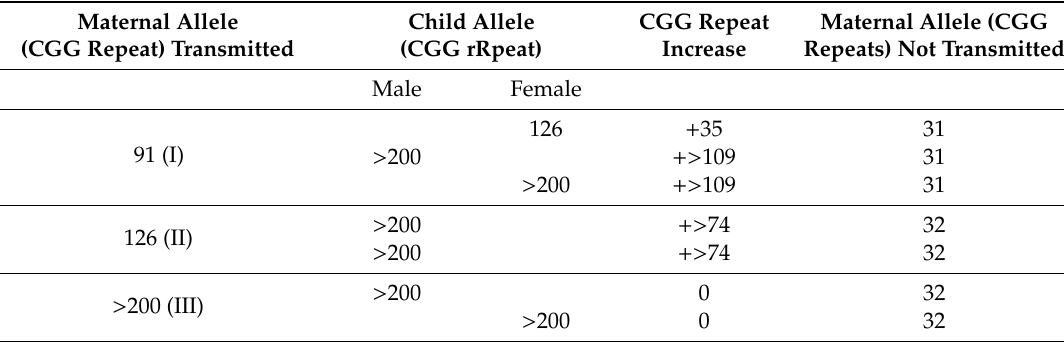
Table 2. Consequences of transmitting a maternal PM